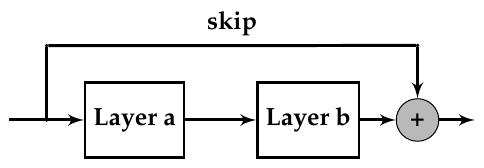
Figure 4. An example of a skip